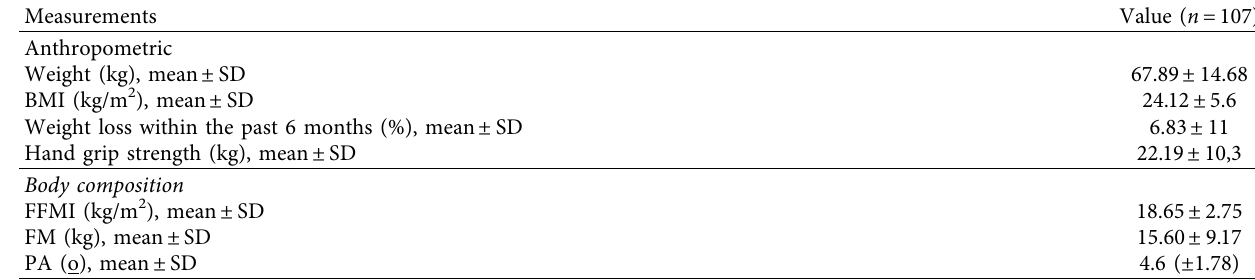
Table 2: Anthropometric and body composition measurements.